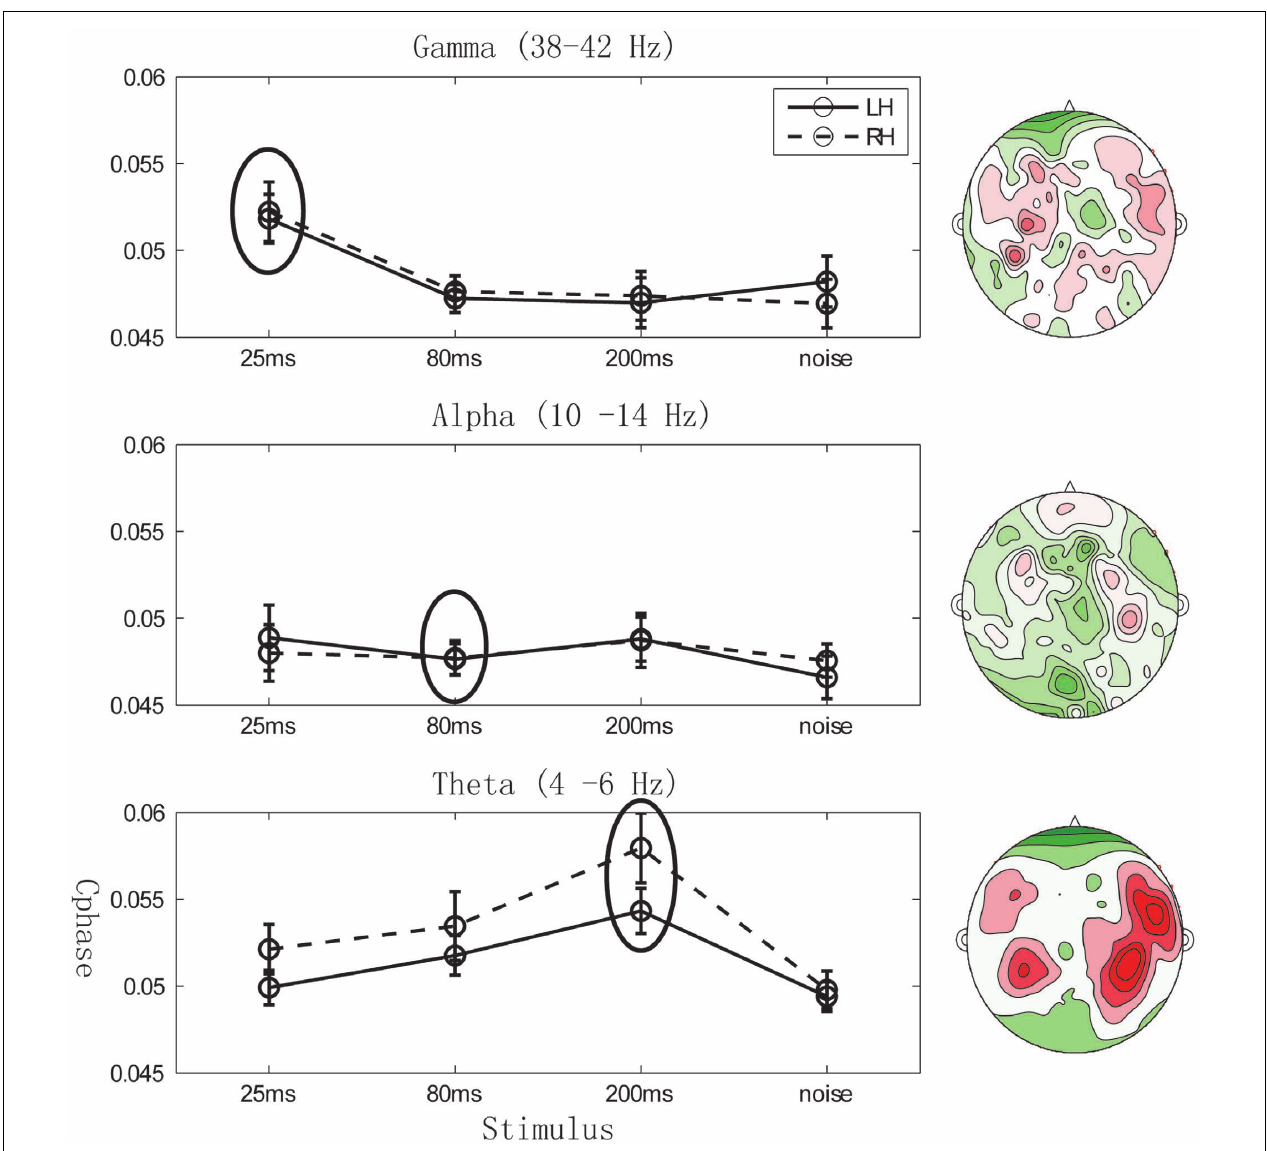
average of “ C phase distribution maps” in the gamma (upper), alpha (middle), and theta (lower) frequency bands for the corresponding matching stimulus (25, 80, and 200ms respectively). All maps are plotted on the same scale (0.03–0.07 green to